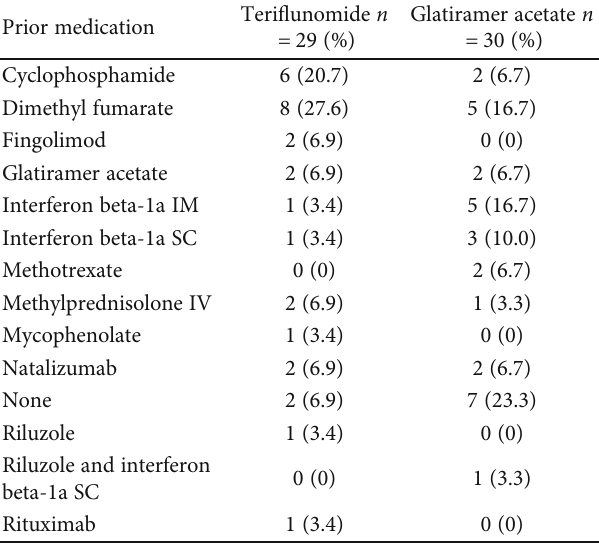
Table 2: Prior medication.